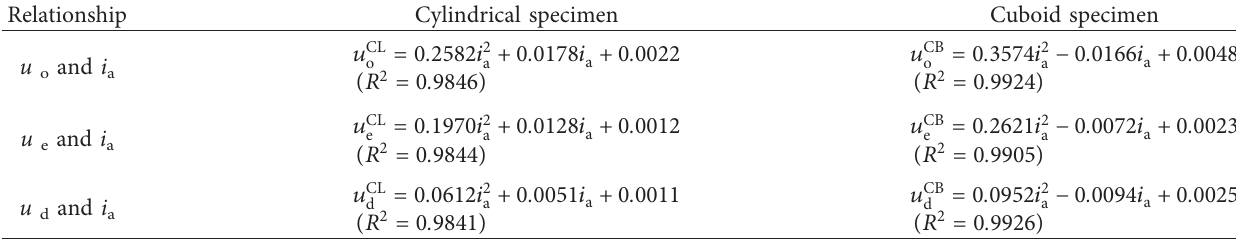
Table 4: Fitting functions among three types of energy densities and the actual unloading